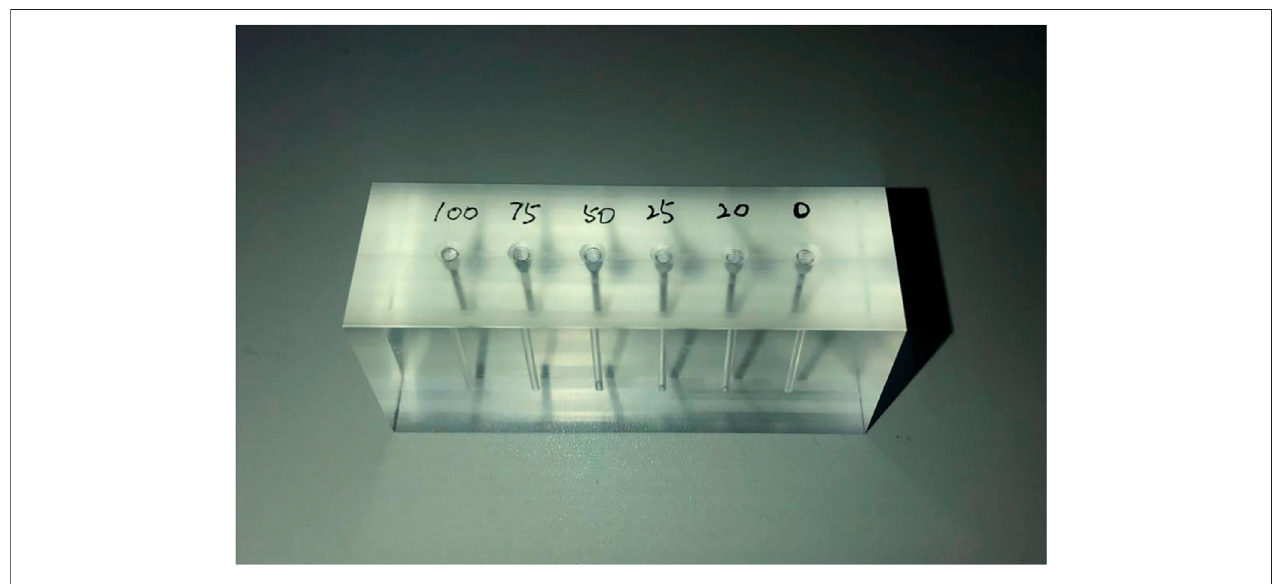
FIGURE 4 | Phantom used in experiments 3.3 and